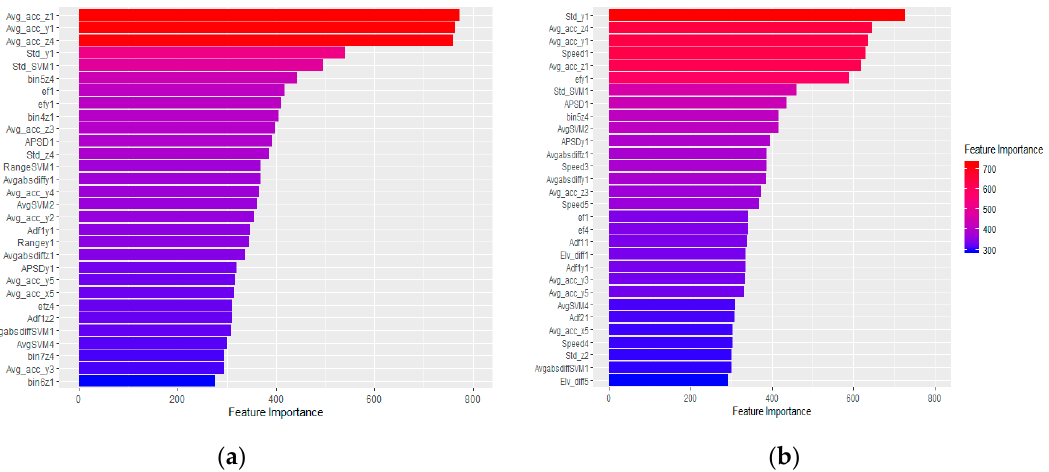
Figure A2. Top 30 important features of a participant’s general RF model (with the highest GPS contribution) trained with semi-structured data (see the feature description in Table A3). ( a ) Accelerometer data only and ( b ) accelerometer and GPS data.